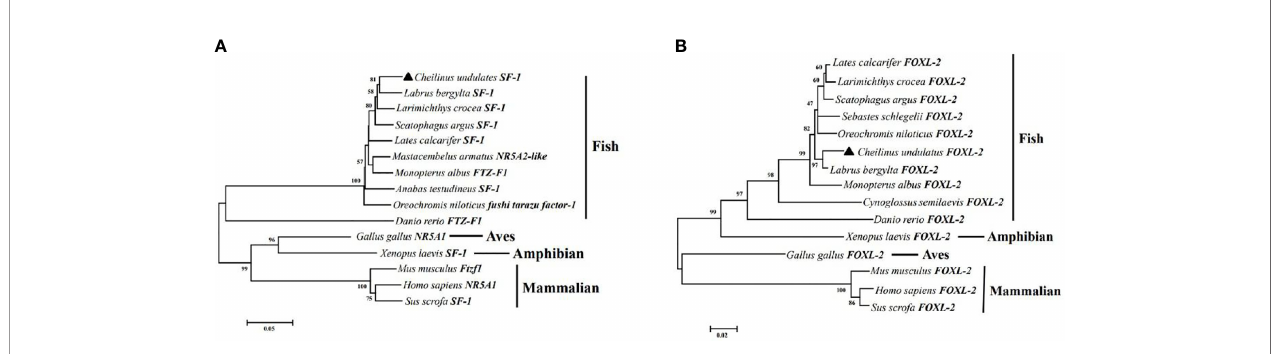
FIGURE 3 | Phylogenetic analysis of C. undulates with other vertebrate SF-1 (A) and FOXL-2 (B) . The pylogenetic tree is constructed using the Mega 5.0 adjacency method. Data were resampled with 1,000